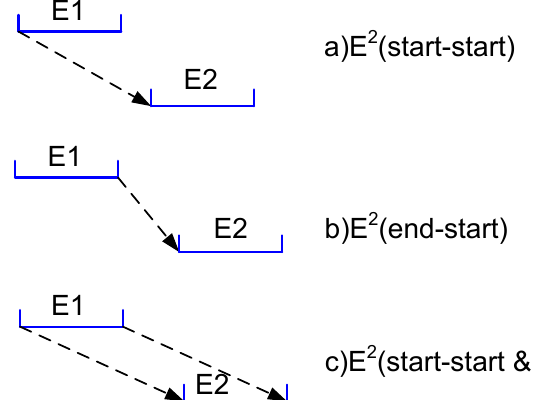
Figure 5. Causality detection based on three different definitions. Each event is presented by a segment. The message passing is presented by a dashed arrow from the sender to the